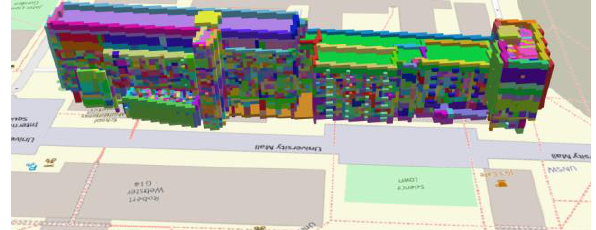
Figure 9 . Visualisation of 1m voxels in QGIS via Qgis2threejs